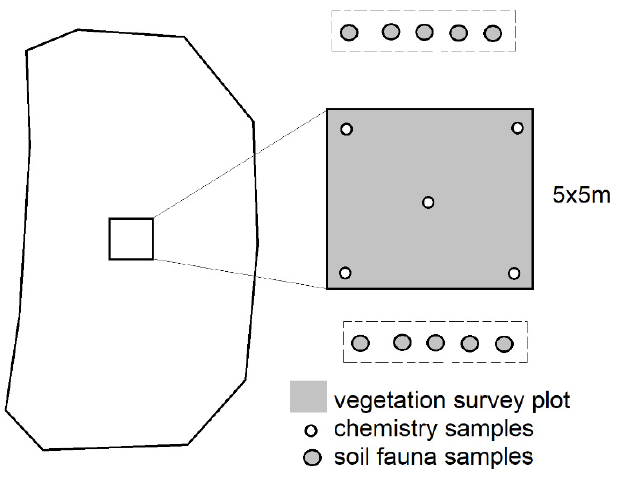
Figure 1. Sampling design applied on individual plots.